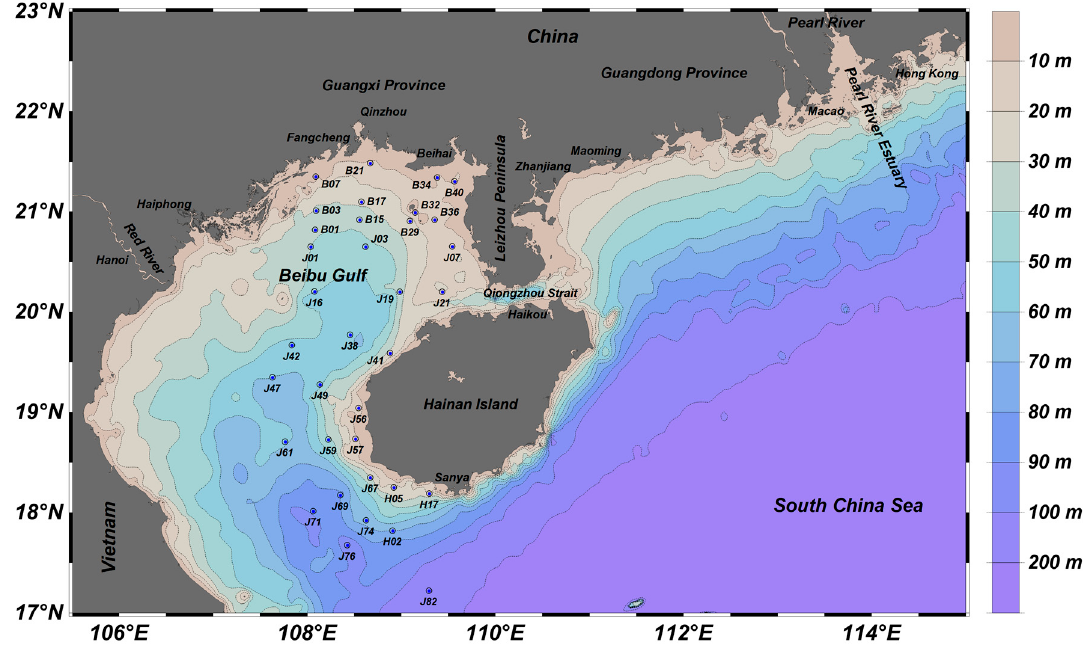
Figure 1. Sampling stations for surface sediments in the Beibu Gulf.